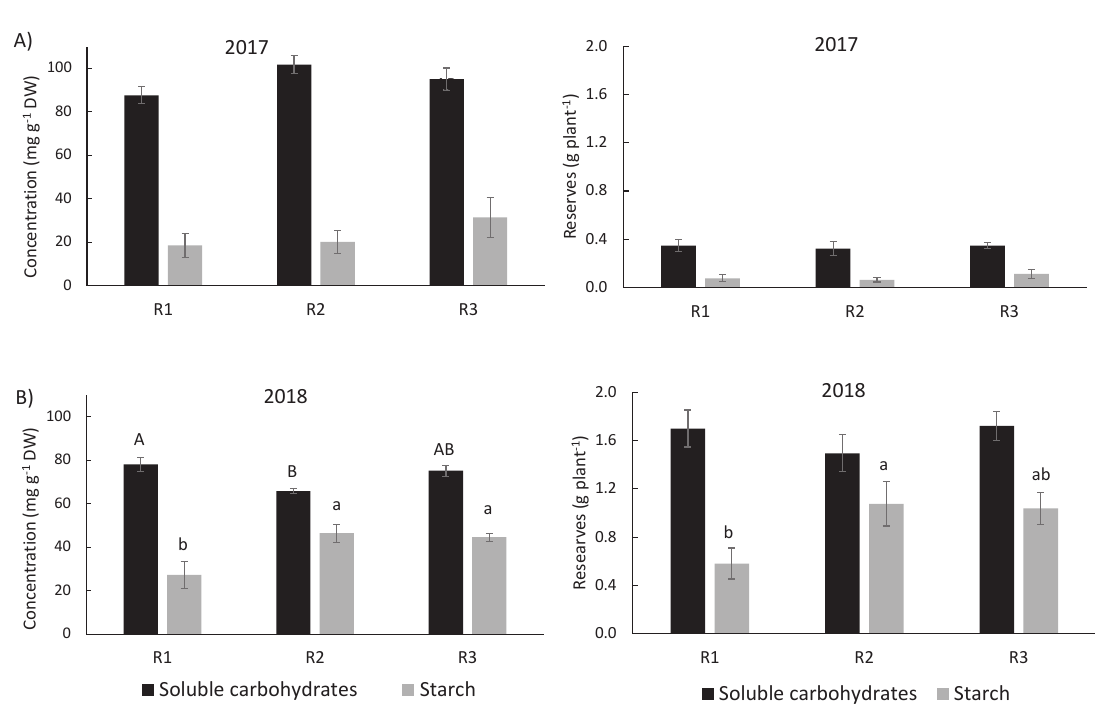
Fig. 2. Soluble carbohydrate and starch concentrations and reserves on 6 November 2017 (A) and 2018 (B) in the crowns of strawberry cv. Polka subjected to different runner removal treatments; R1 = runners removed three times in three weeks intervals beginning at the end of July, R2 = runners removed once on 27 August 2017 / 10 September 2018, R3 = control, no runner removal. Vertical bars represent ± SEM, n = 4. Values marked with the same letter are not significantly different at p < 0.05 by Tukey’s test.